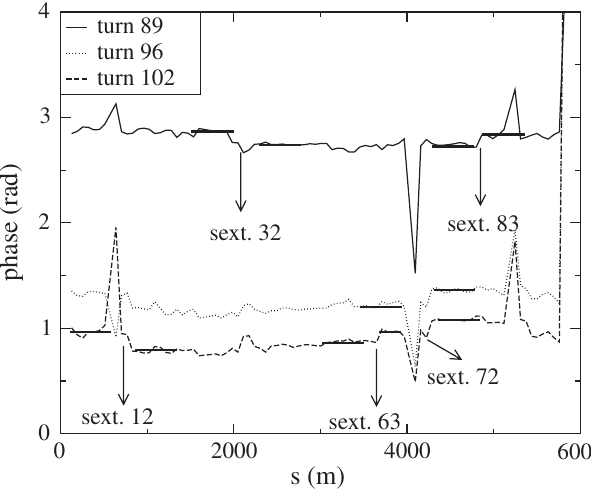
FIG. 10. Phase analysis of a SPS turn by turn difference orbit. The sextupoles that were intentionally introduced in the accel- erator can be clearly identified by the jumps in phase (taken from Ref. [17]).